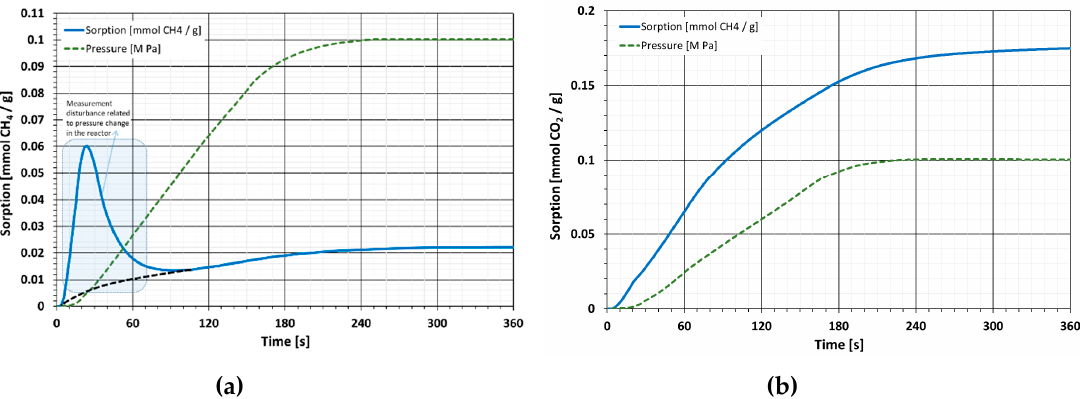
Figure 11. Diffusion kinetics of raw halloysite: ( a ) diffusion kinetic of CH 4 ; ( b ) diffusion kinetic of CO 2 .